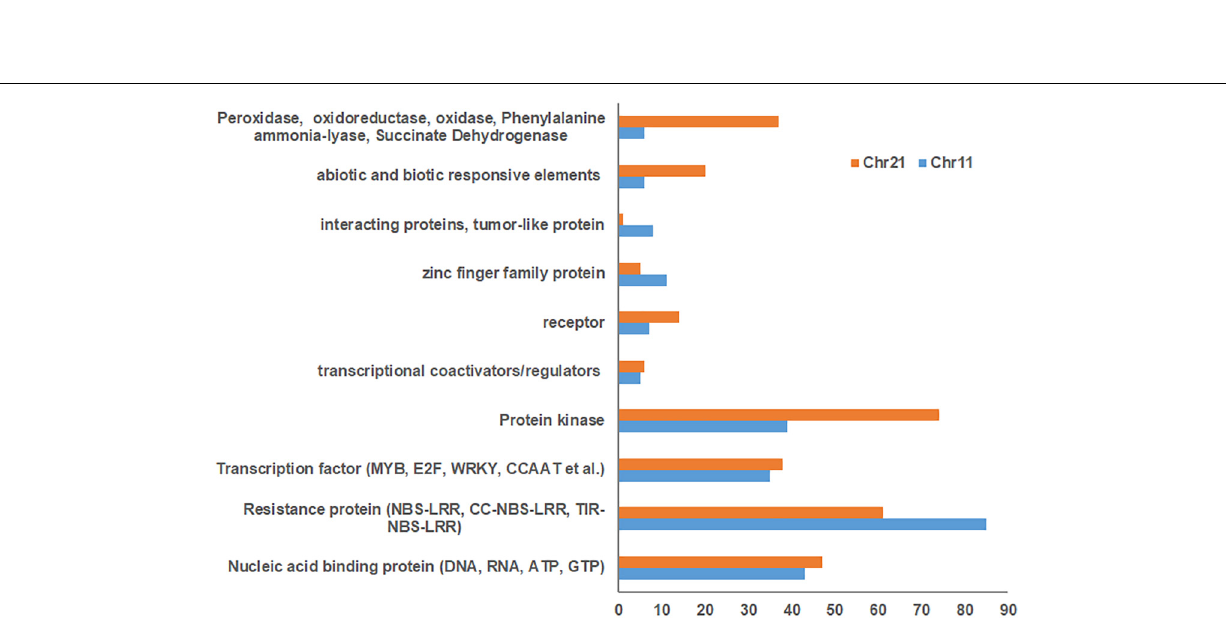
Frontiers in Plant Science |